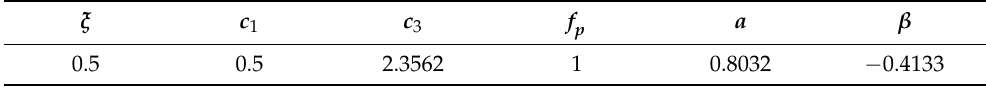
Table 1. Primary resonance dynamic response parameter